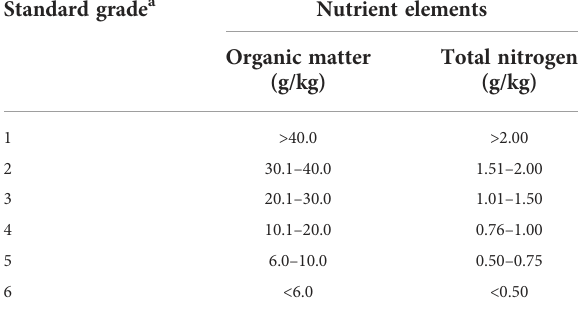
TABLE 1 National soil nutrient standard